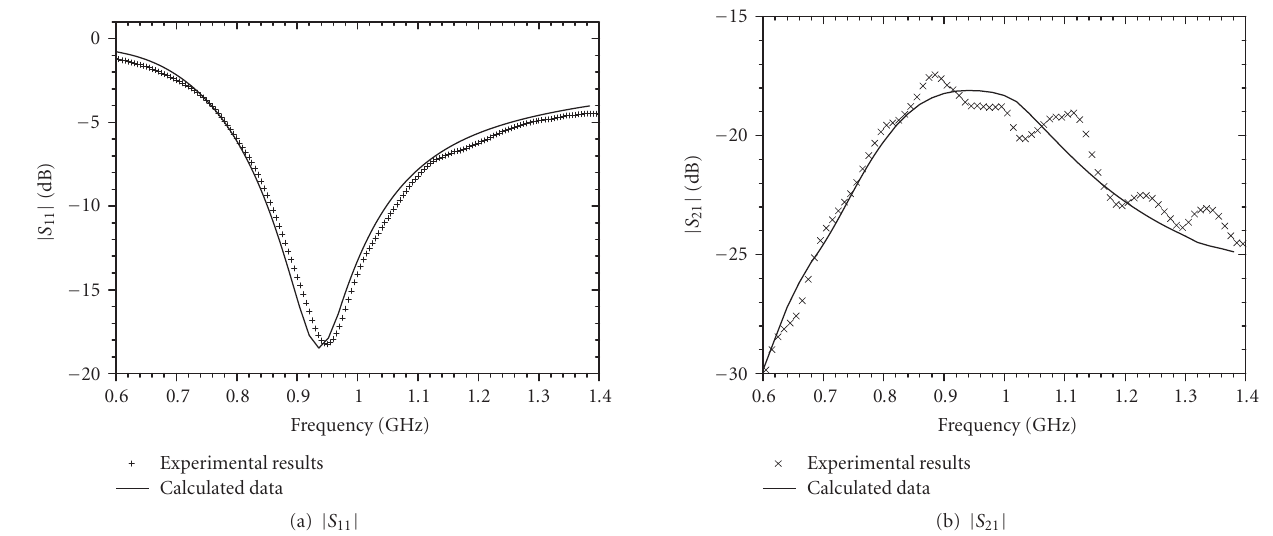
Figure 4: Simulated and measured S -parameters of the two-monopole antenna ( D = 320mm).